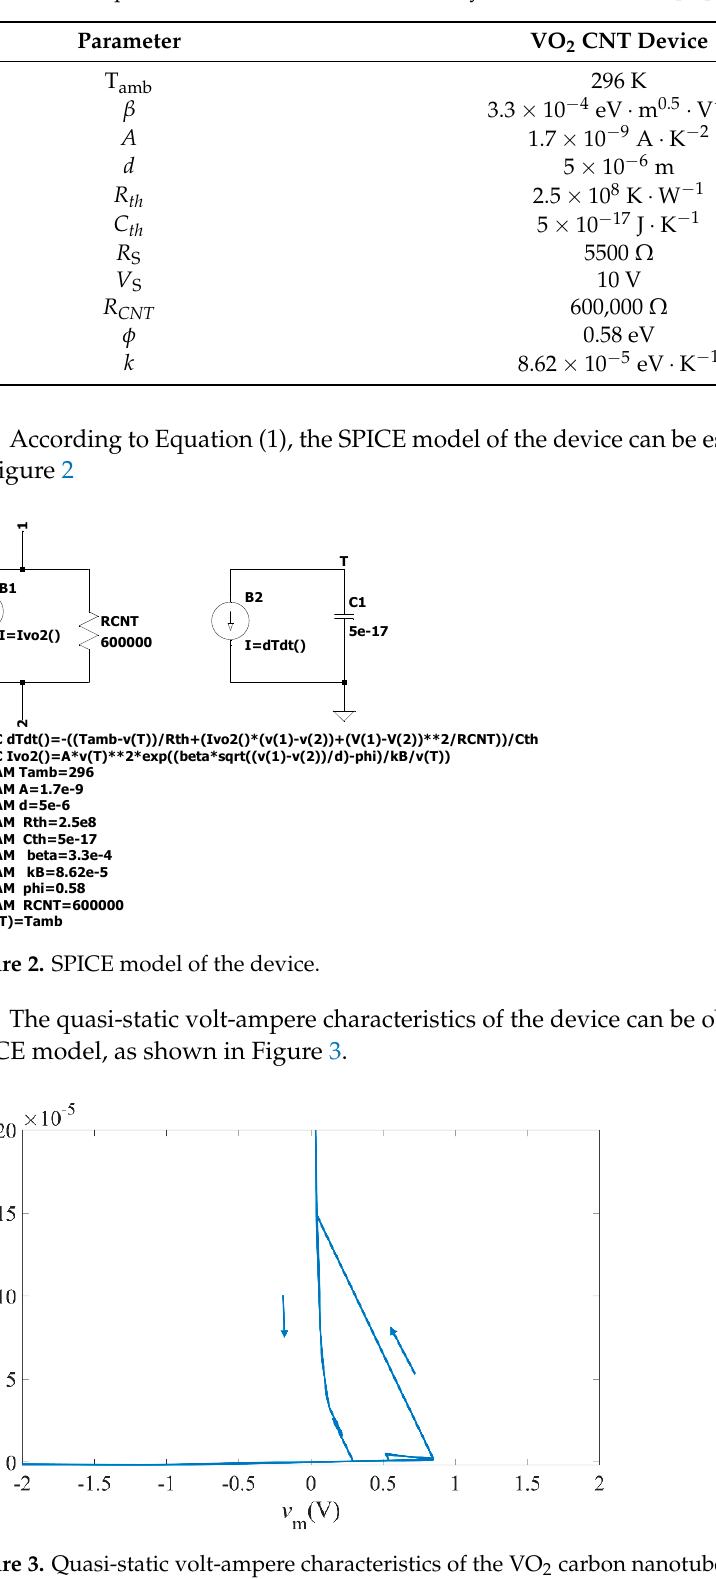
Table 1. Device parameters. The data is cited directly from the literature [16].